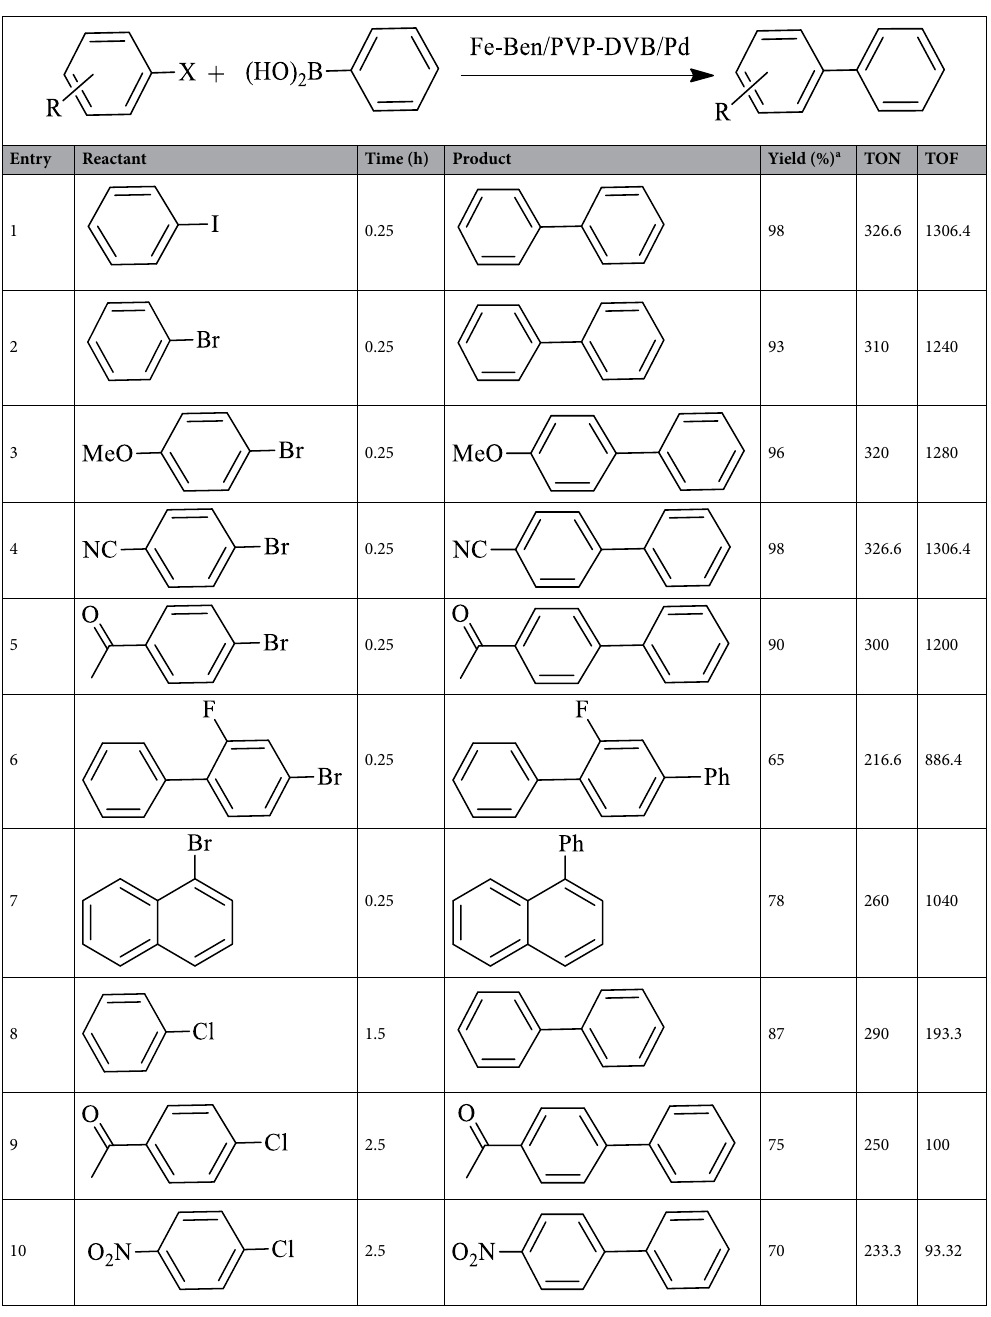
Table 2. Synthesis of biphenyl with different aryl halides under optimal conditions in the presence of Fe-Ben/ PVP-DVB/Pd nanocatalyst. Reaction condition: 0.6 mmol phenylboronic acid, 0.4 mmol K 2 CO 3 , 0.5 mmol of aryl halide in 2 mL solvent (EtOH/H 2 O1:1), and in the presence of 0.3 mol% Pd nanocatalyst at 60 °C. a Isolated yield. TON: (yield of product/per mol of Pd). TOF: (TON/time of